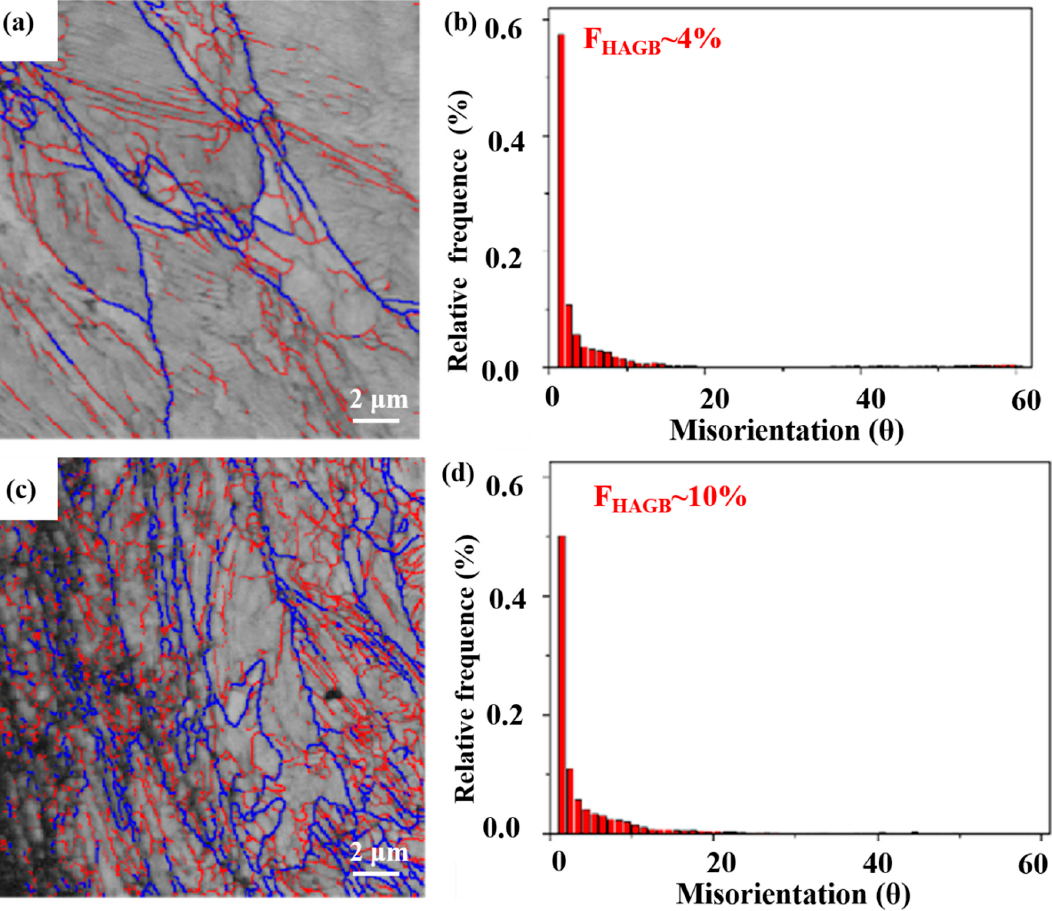
Figure 8. The EBSD micrographs: ( a , b ) the grinding processing sample and ( c , d ) the sample after SURT with 0.4 MPa. (Red lines (low-angle grain boundary): 2° < θ < 10°; blue lines (high-angle grain boundary): θ > 10°.)